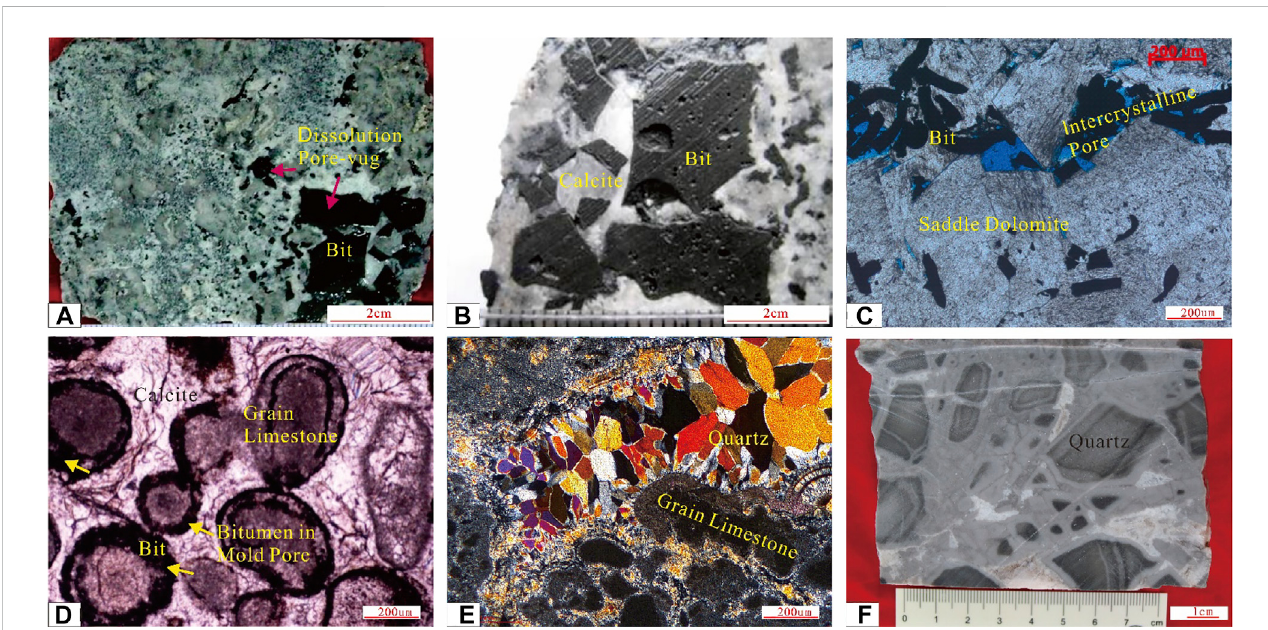
FIGURE 6 Occurrence of bitumen and siliceous hydrothermal metasomatism in the Ordovician carbonate reservoir in the Gucheng area. (A) . Bitumen in the dissolution pore-vug, Well GC4, Penglaiba Formation, 6,509 m; (B) . bitumen in the stylolite and structural fracture, with vesicles occurring on the bitumen surface, Well GC4, Yijianfang Formation, 5,597 – 5,600 m; (C) bitumen in the intercrystalline pore of dolomite, Well GC9, Yingshan Formation, 6,097.8 m; (D) bitumen in the mold pore, Well GC7, Yijianfang Formation, 5,662 m; (E) siliceous hydrothermal fi lling, Well GC15, Yingshan Formation, 6,356.7 m; (F) siliceous hydrothermal fi lling, Well GC14, Yingshan Formation, 6652